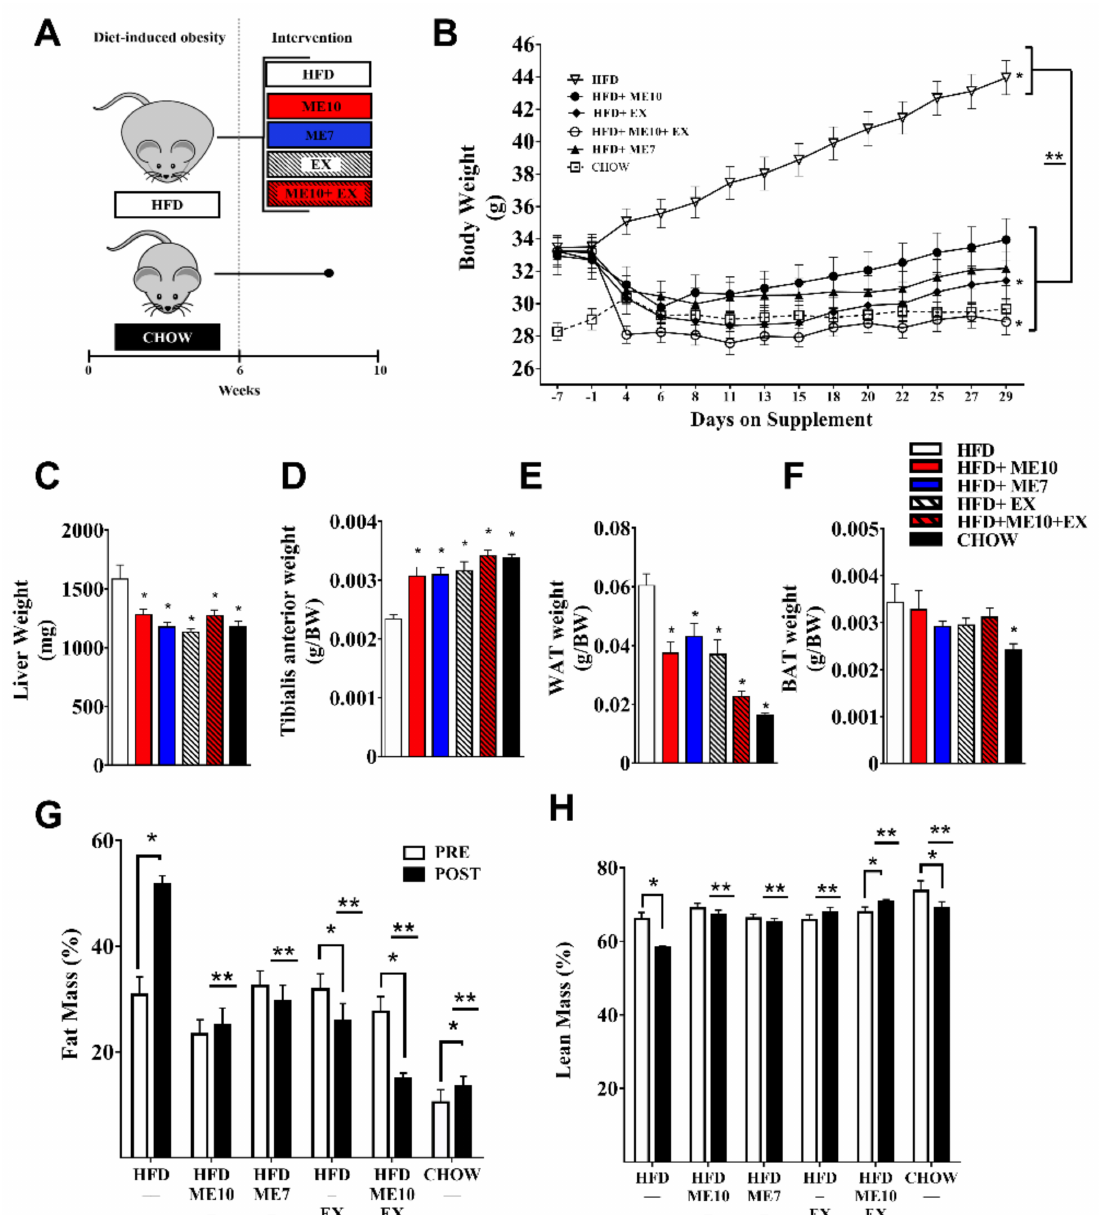
Figure 1. Metabolic enhancer (ME) supplementation and/or exercise stimulated weight loss despite the continuous provision of a high-fat diet. Experimental approach ( A ). Beginning at 6 weeks of age, C57BL6J mice consumed a high-fat diet (HFD) for 6 weeks. Animals subsequently remained on HFD but received ME supplementation and/or performed exercise for 4 weeks. Body weight ( B ) was measured throughout the experiment. Weights compared by 2-way RM ANOVA. *: p < 0.05 compared to Pre (Day -1) within groups, **: p < 0.05 compared to HFD following intervention. Relative tibialis anterior muscle weight ( C ), liver weight as a marker of hepatomegaly ( D ), relative intra-abdominal white adipose tissue (WAT) weight ( E ), and relative brown adipose tissue (BAT) weight recorded following animal sacrifice ( F ). 1-way ANOVA with Fisher’s LSD post-hoc test. *: p < 0.05 compared to the high-fat diet (HFD) group. Relative fat mass ( G ) and relative muscle mass ( H ) were recorded prior to (Pre, open bars) and following (Post, filled bars) using the Bruker minispec LF90II Body Composition Analyzer (NMR). Body composition compared by 2-way RM ANOVA. *: p < 0.05 compared with Pre within groups, **: p < 0.05 compared to HFD following intervention (filled bars). Data are represented as mean ±